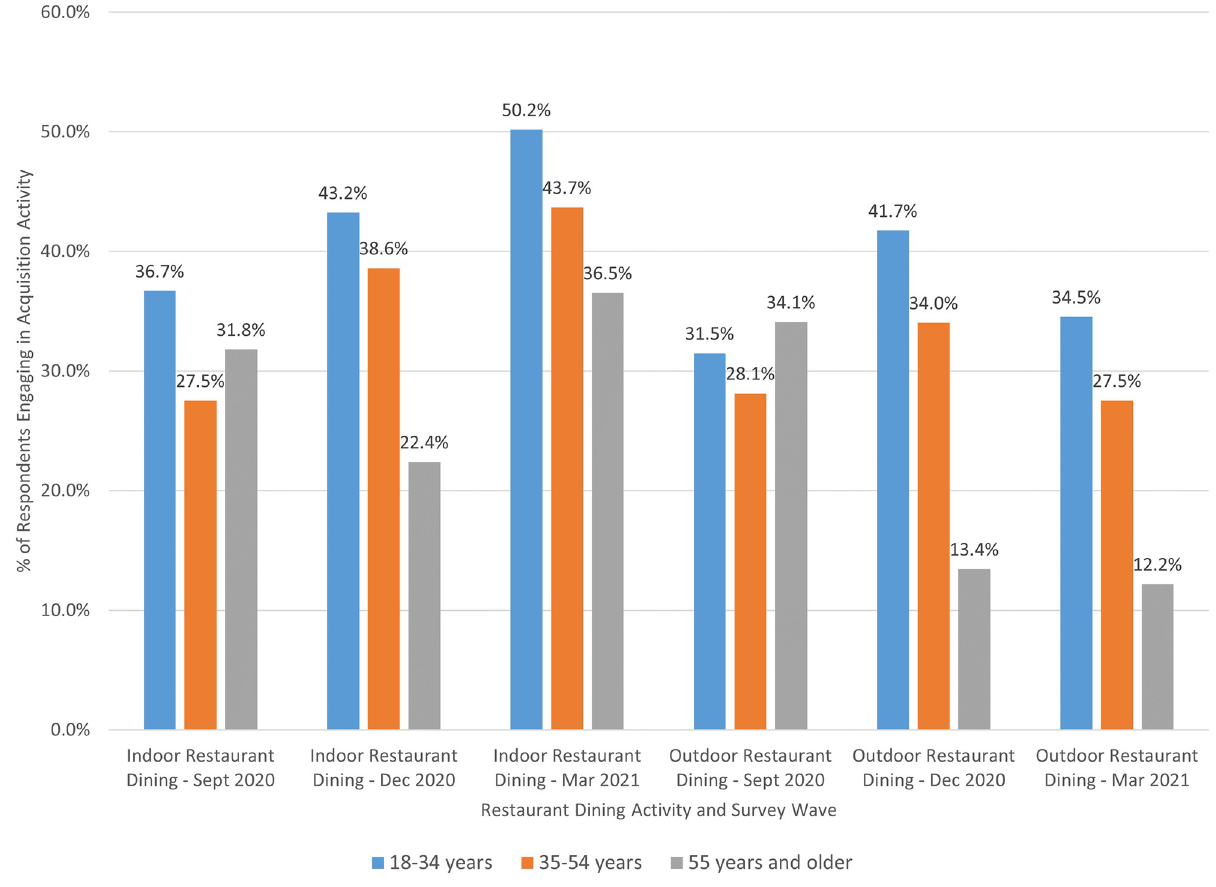
Fig 2. Restaurant dining behavior by survey wave and age